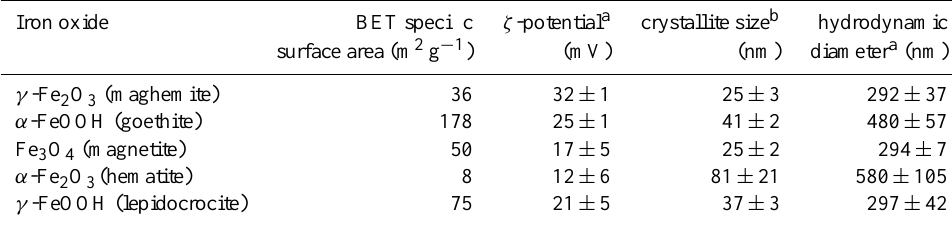
Table 1. Summary of the properties of iron oxide